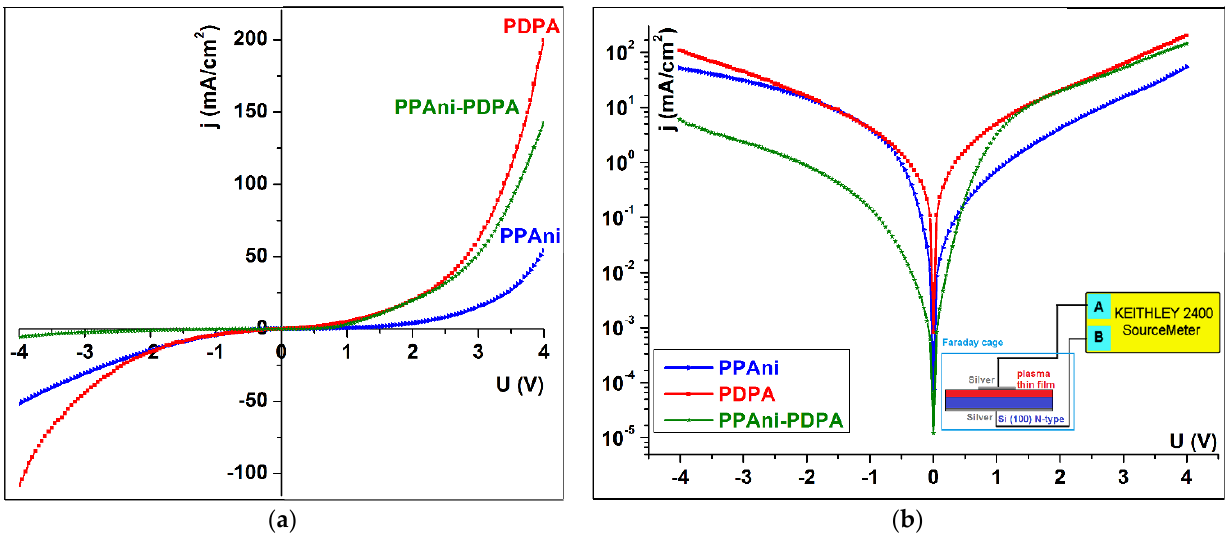
Figure 11. The plot of the current–voltage of the PPAni, PDPA, and PPAni-PDPA ( a ) linear plot; ( b ) semi-log plot.